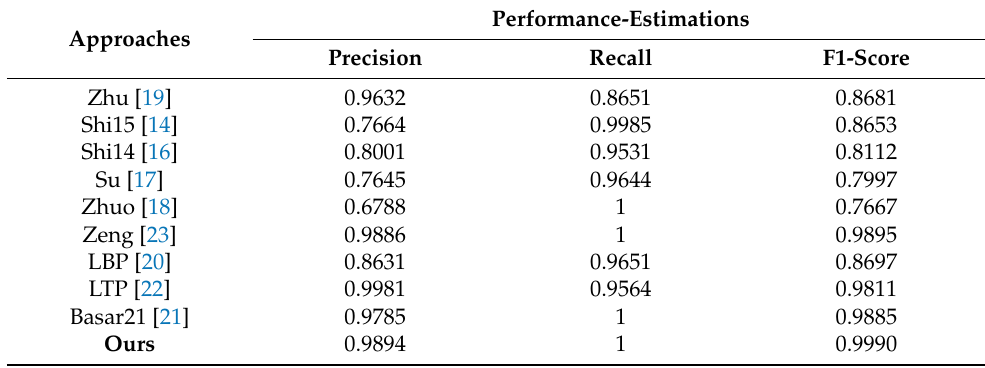
Table 4. Performance-Estimation of numerous approaches.